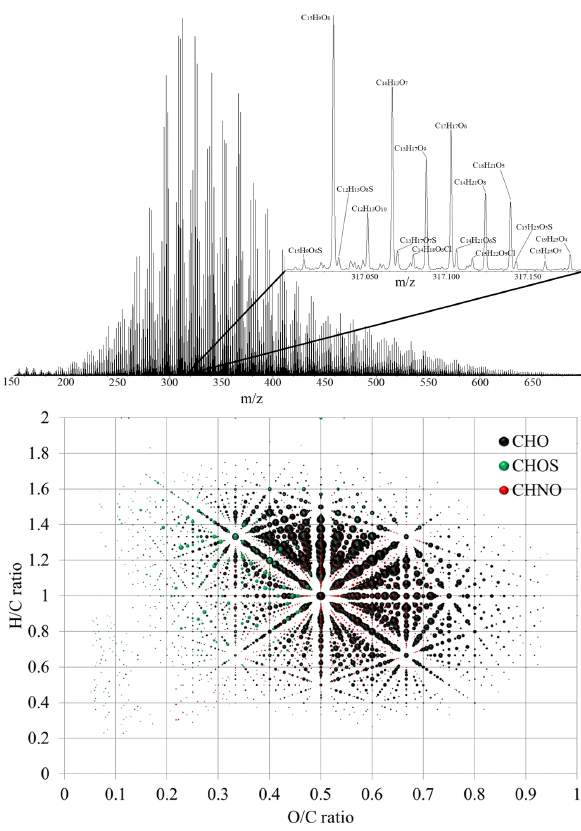
from a boreal lake at the surface in April 2011 in Sweden (Lill- sjön) and the van Krevelen diagram of CHO, CHOS and CHNO formulae. Note: size of bubbles represent relative abundances of as- sociated mass